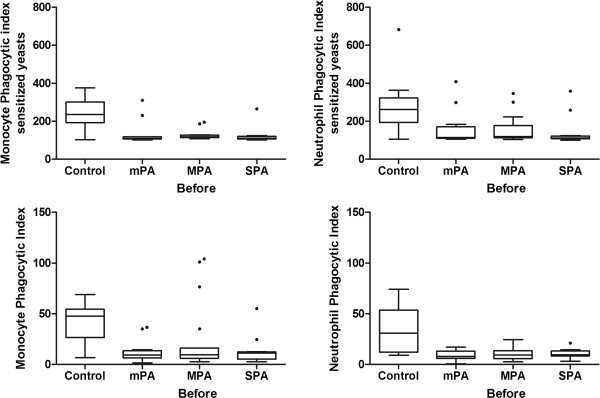
In vitro evaluation of the phagocytic indices of monocytes (left) and neutrophils (right) in individuals with mild persistent asthma (mPA), moderate persistent asthma (MPA) and severe persistent asthma (SPA) before treatment and in normal control children using 2.5×105 yeast cells per well. For the top panels, sensitized yeasts were used. For the bottom panels, non-sensitized yeasts were used. Statistical analyses showed that the median value of all groups of asthmatic children was lower than that of the healthy control children; however, no difference was observed between the groups with mild, moderate and severe persistent asthma (Kruskal-Wallis test followed by the Dunn’s method). The data are expressed as the median, quartile and extreme, and outlier values are marked.